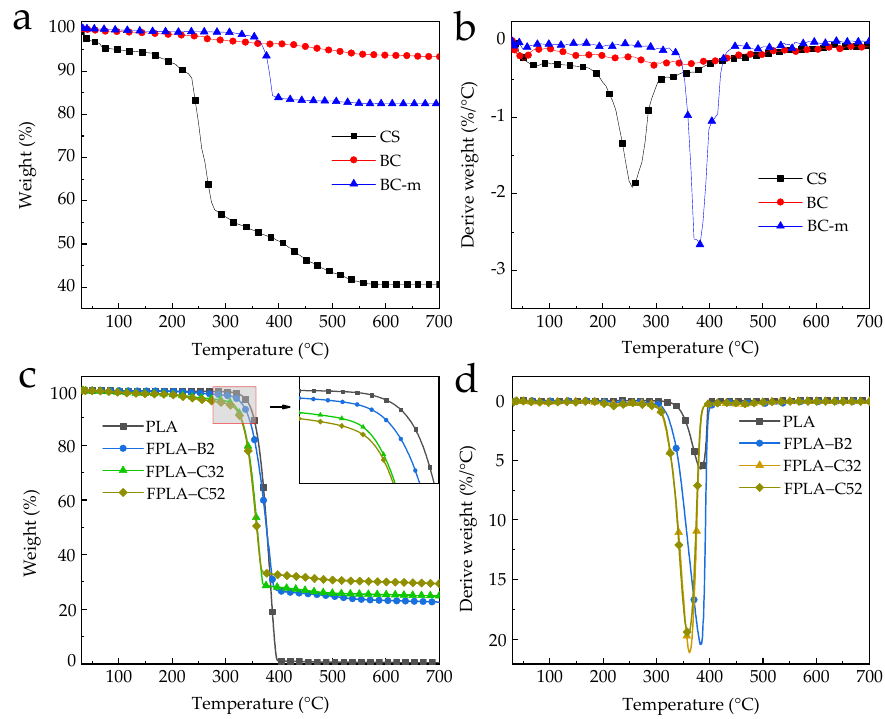
Figure 8. Typical TGA ( a , c ) and DTG ( b , d ) curves of CS, BC; BC-m, PLA, and FPLA composites in N 2